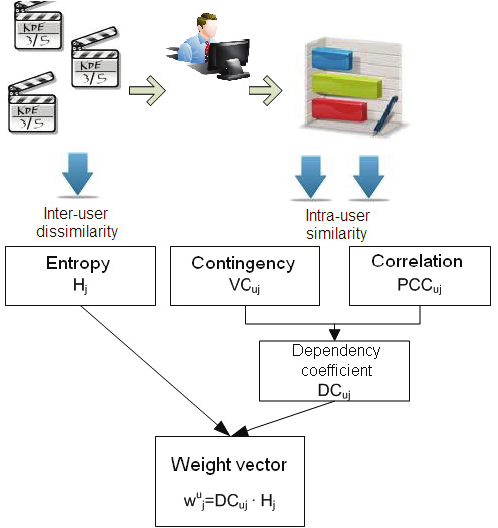
Fig. 1. Feature weighting